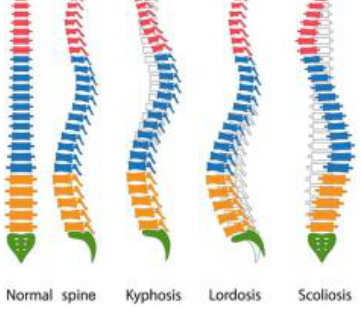
Figure 3. Different types of spine deformities (Source: news-medical.net)